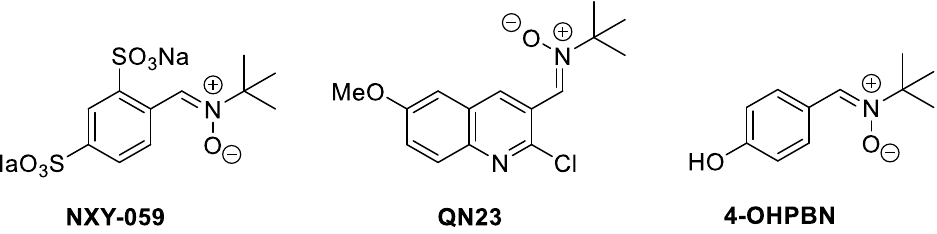
Figure 1. Examples of biologically active nitrones.